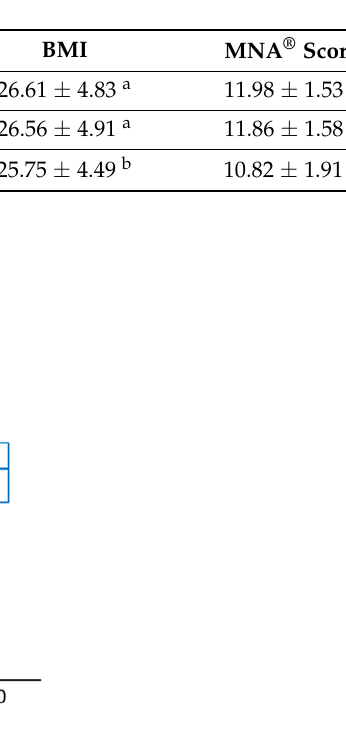
Figure 1. Boxplot depicting the population’s weight at each data collection. ns, no significant differ-